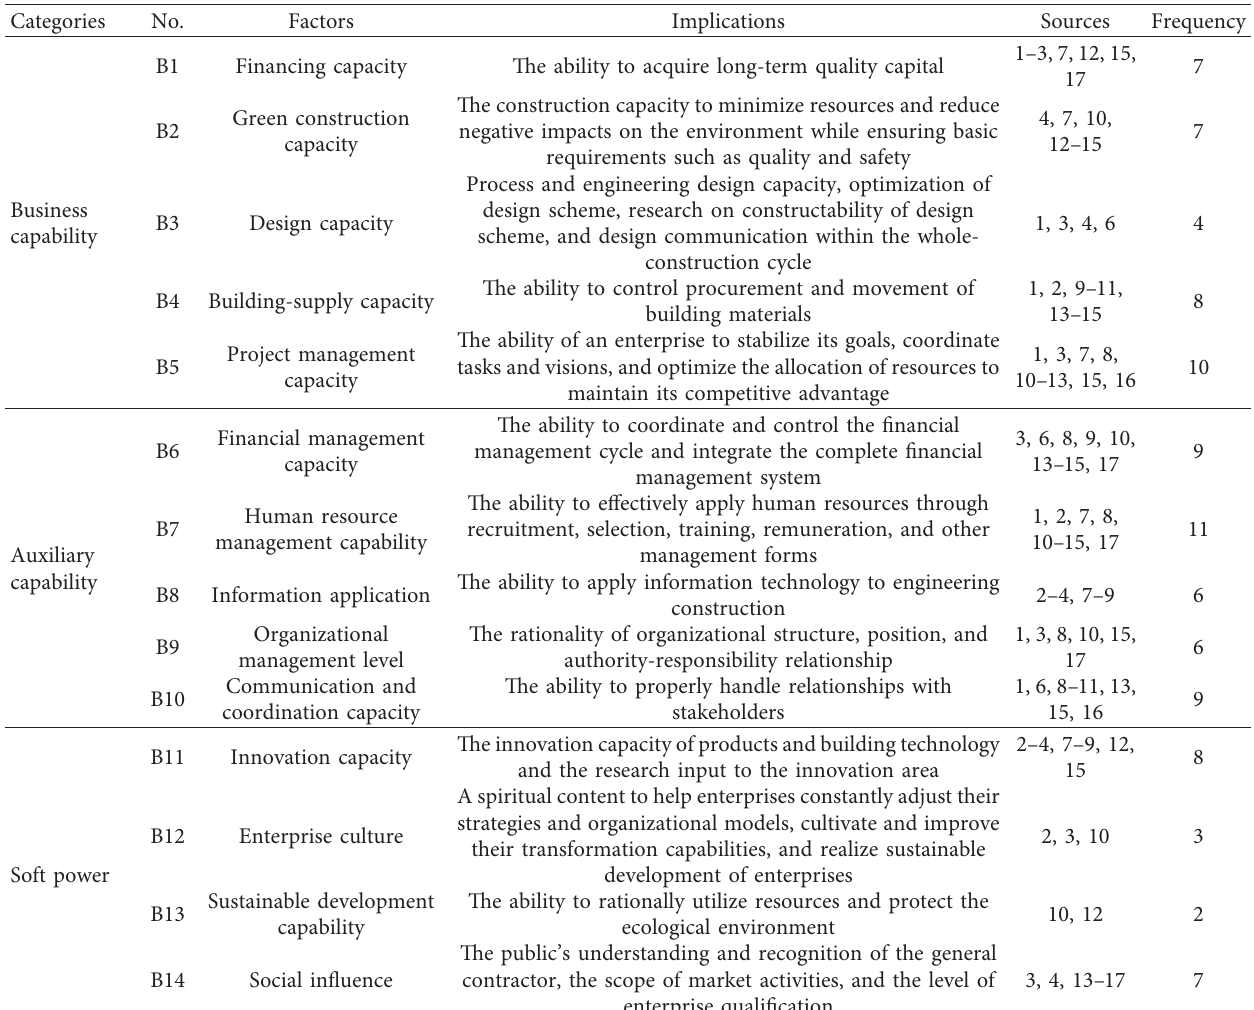
Table 2: Factors influencing the capability of general